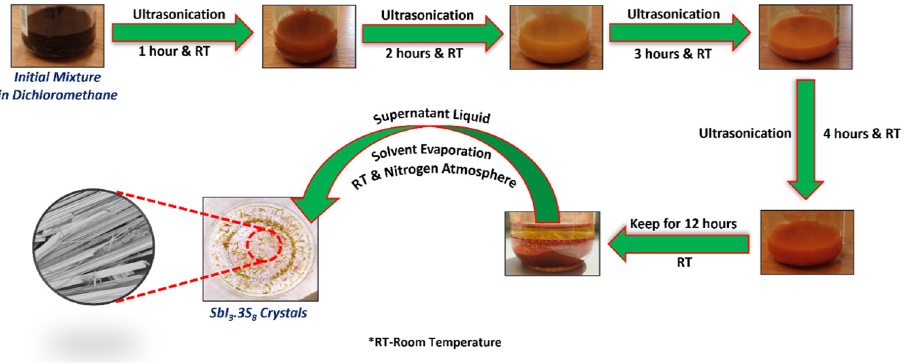
Figure 2. Digital images of each step of the synthesis of SbI 3 •3S 8